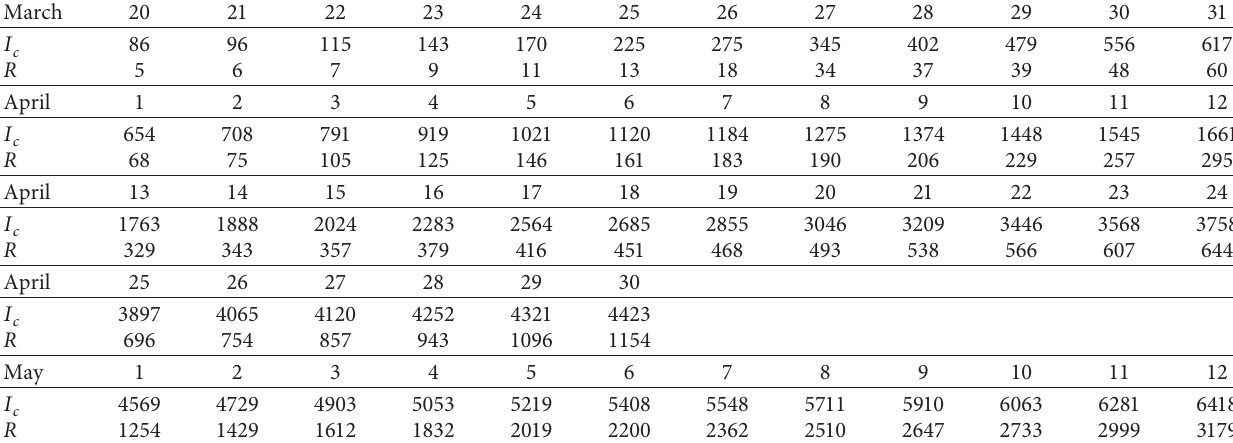
Table 1: Cumulative daily reported data of confirmed and removed cases form March 20, 2020, to May 12, 2020, reported by the Ministry of Public Health in Morocco and available in [36].